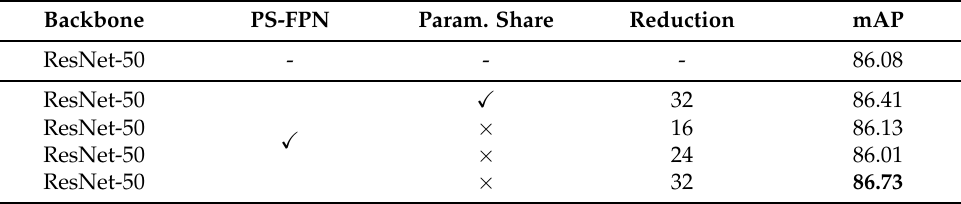
Table 3. Analysis of position-sensitive feature pyramid network on HRSC2016